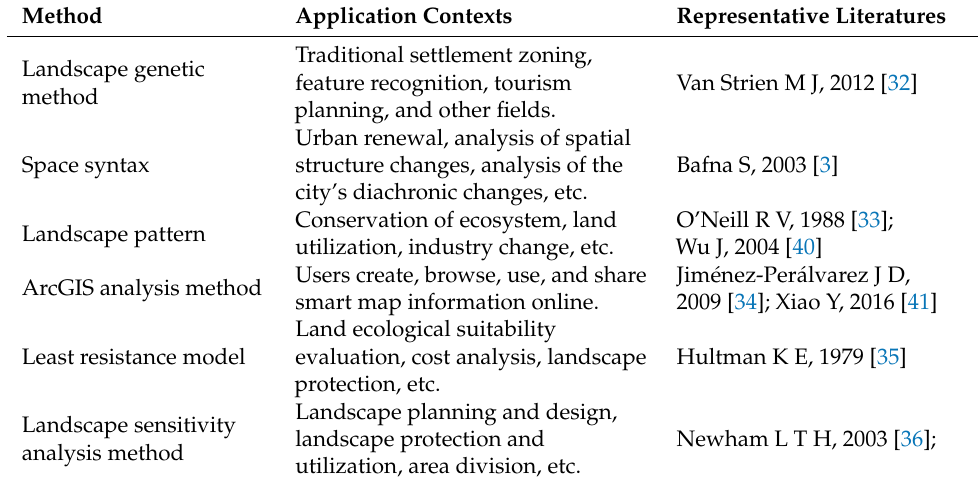
Table 1. Comparison of the methods applied in landscape